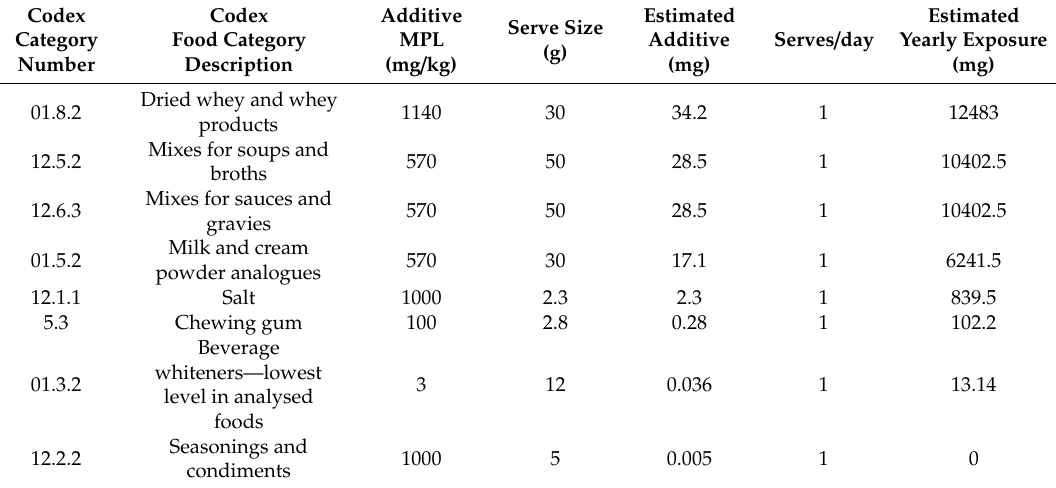
Table 3. Example of Food Additive Modelling Using